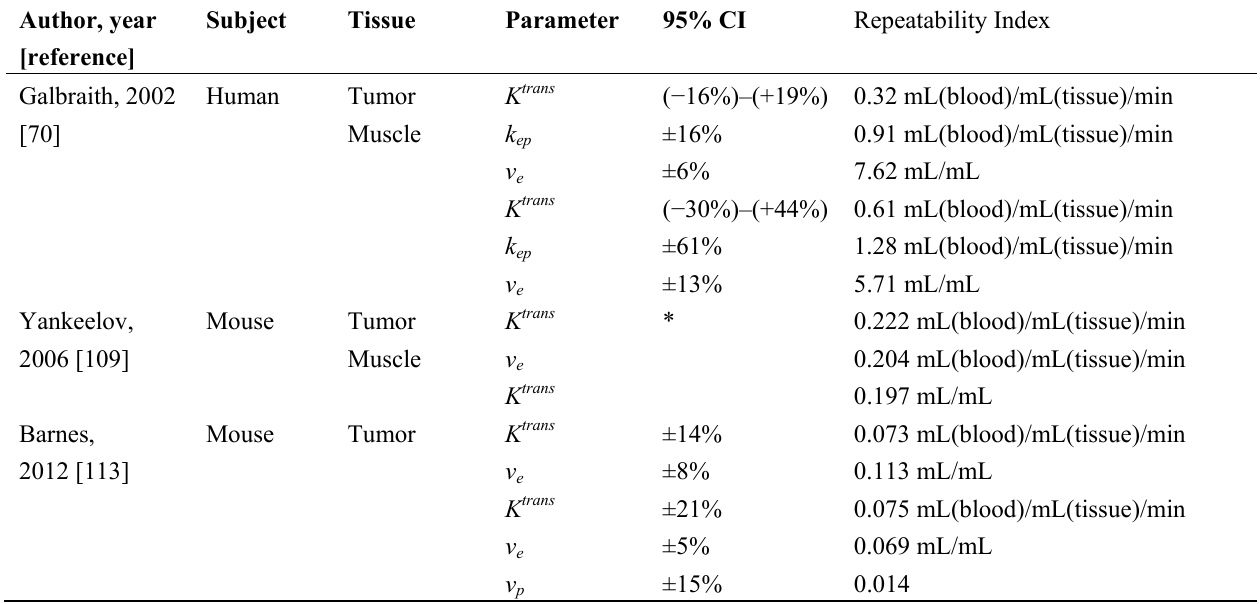
2. Dynamic contrast enhanced magnetic resonance imaging (DCE-MRI) reproducibility data for human and small animal